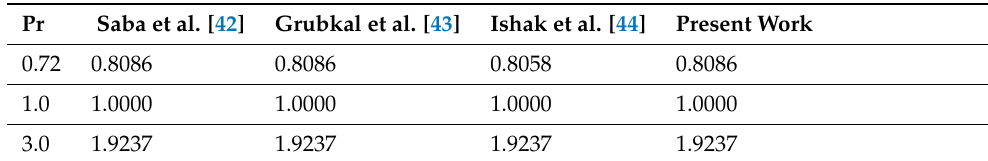
Table 2. Comparison of the current results with those from previous published research with different values of Pr by taking Lt = φ 1 = φ 2 = K 1 = A 1 =